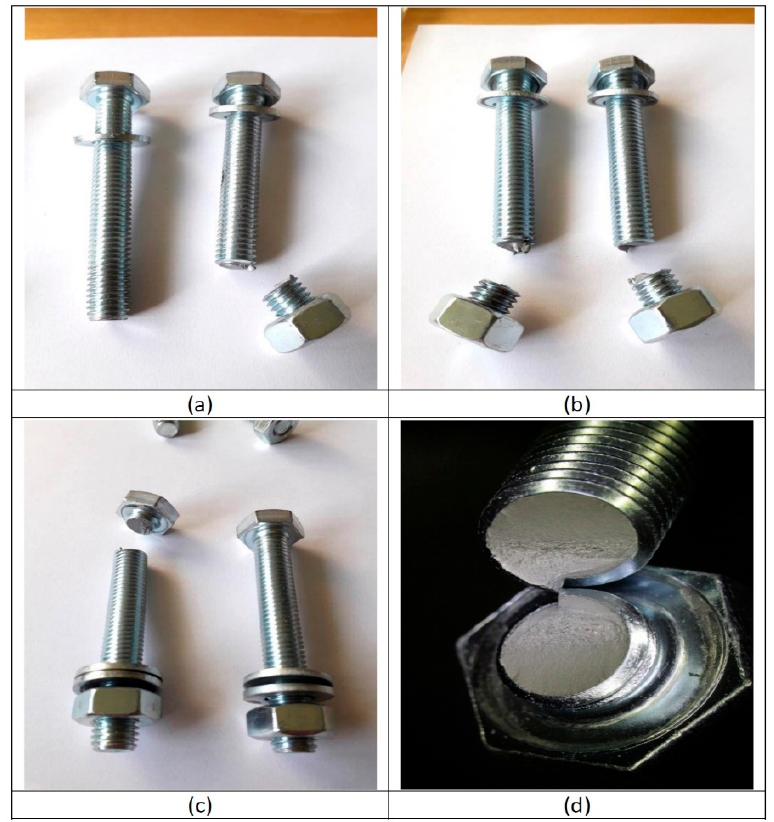
Figure 10. Bolt failure: ( a ) failure of one bolt at nut location; ( b ) failure of both bolts at nut location; ( c ) failure of one bolt at head location; ( d ) appearance of the fracture surface.